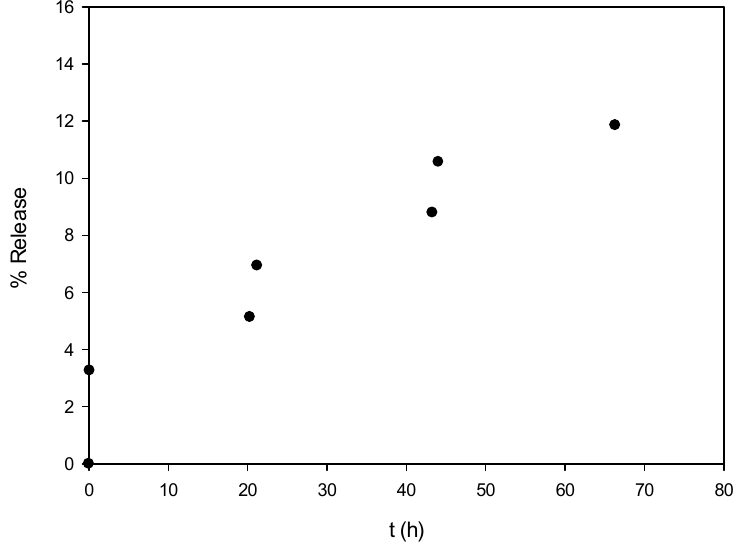
Figure 3. Release profile of Irgarol from loaded PLA nanoparticles.